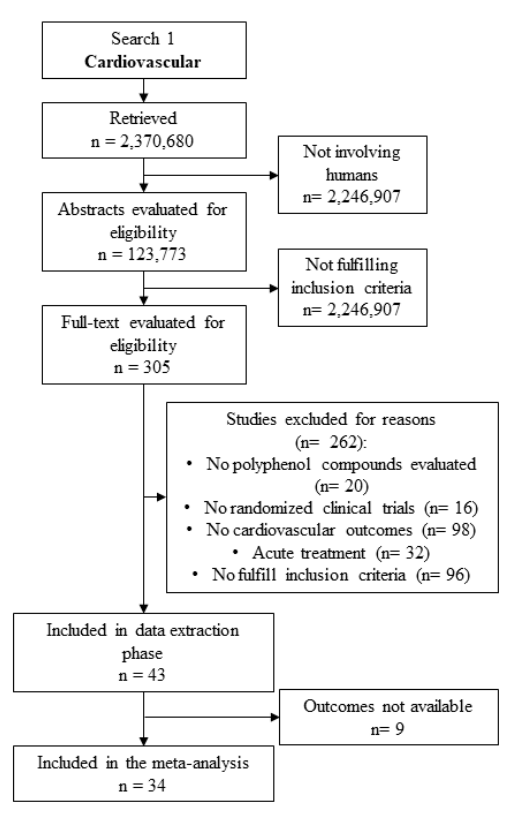
Figure 1. Literature search flow chart for meta-analysis on cardiovascular outcomes.